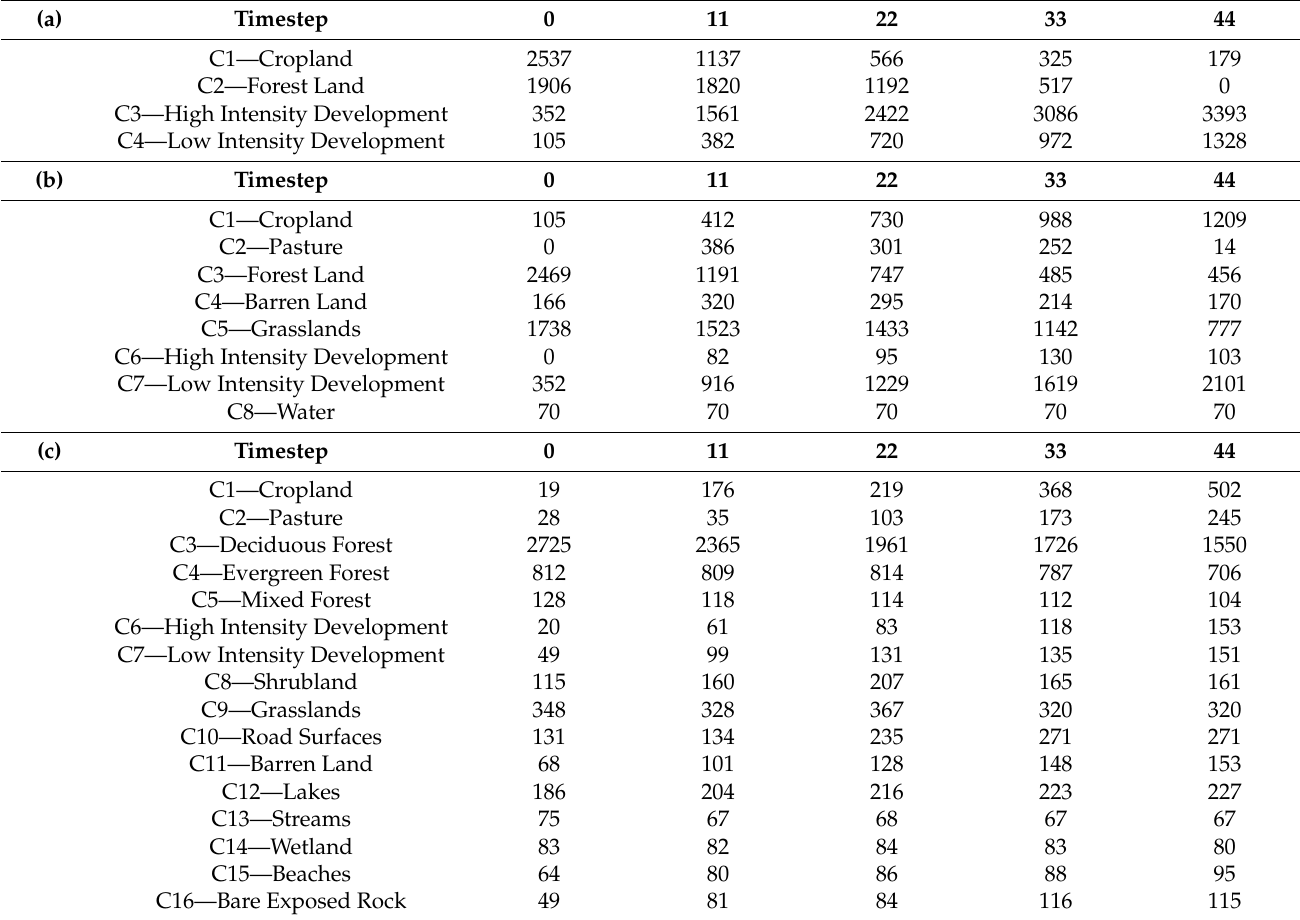
Table 3. Number of cells belonging to each class at various timesteps (considering 11-year temporal resolution) in